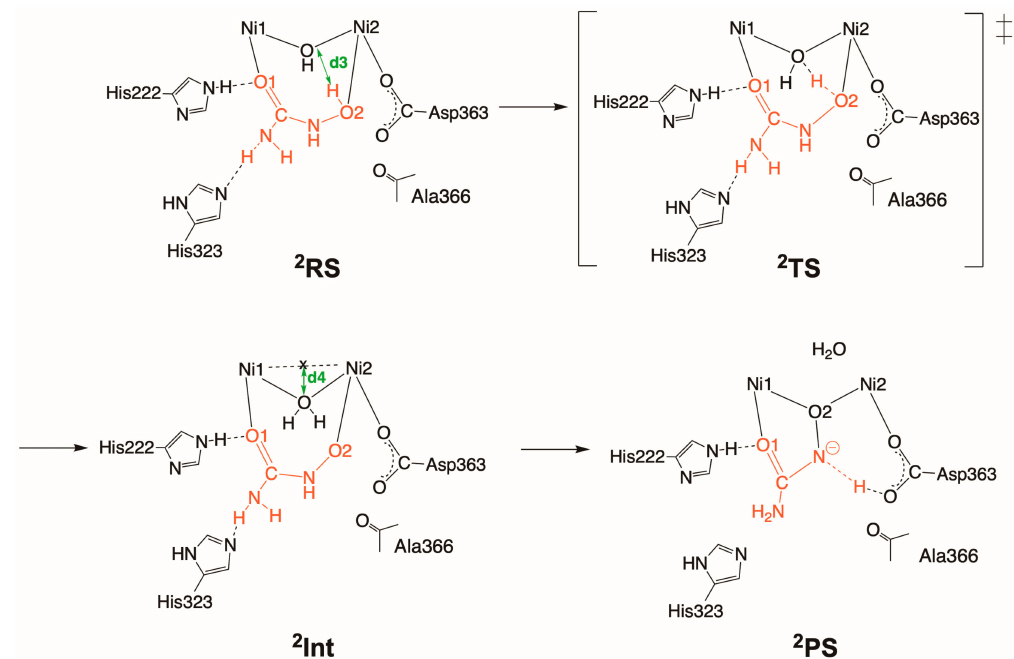
Scheme 3. Reaction mechanisms for HU ( 2 ) binding to the dinickel center, starting with the HU- bound complex ( 2 RS ) and followed by 2 TS , 2 Int , and the HU-inhibited complex ( 2 PS ). The active-site residues of the QM region that may interact with HU (His222, His323, Ala366) are also shown. Reaction coordinates (interatomic distances d3 and d4) are defined as collective variables.